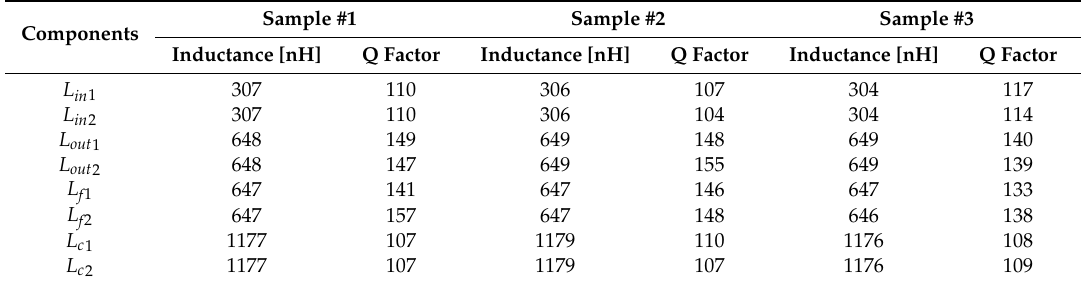
Table 3. Inductances and quality factors of the inductors used in the fabricated power modules. Components